Question: In one sentence, what is this figure communicating?
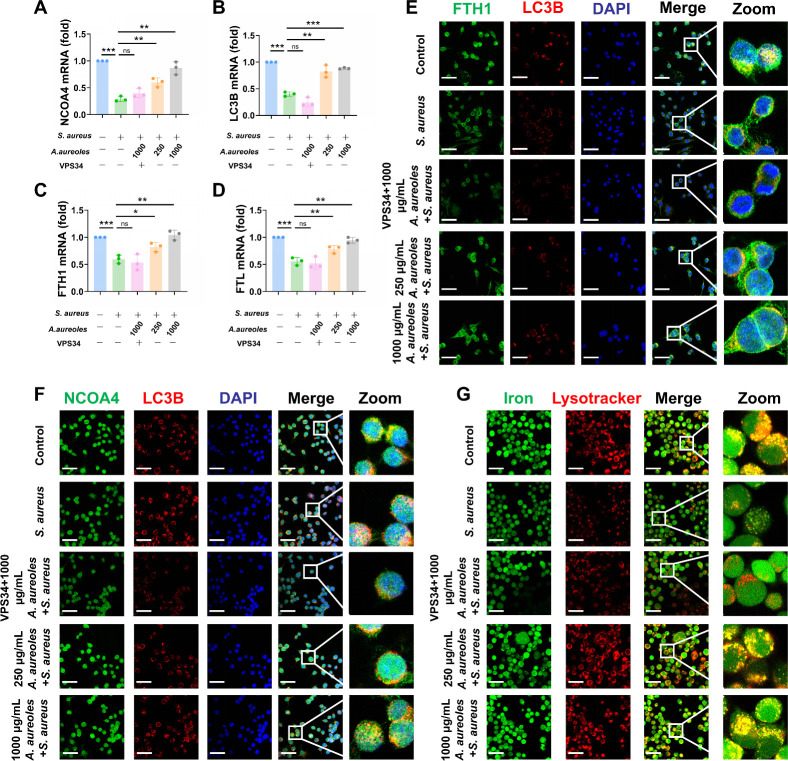
Answer: A. aureoles GGNSJ001 protects RAW 264.7 cells against S. aureus -triggered ferritinophagy. RAW 264.7 cells were treated with S. aureus (MOI = 10) for the indicated time. VPS34 and A. aureoles GGNSJ001 were added to RAW 264.7 cell culture medium before and after S. aureus infection for the indicated time. The relative mRNA levels of NCOA4 ( A ), LC3B ( B ) , FTH1 ( C ), and FTL ( D ) were assessed by q-RT-PCR. RAW 264.7 cells were subjected to immunofluorescence microscopy with antibodies against FTH1 (green) / LC3B (red) ( E ) and NCOA4 (green) / LC3B (red) ( F ). The content of Fe 2+ in lysosomes was determined using Calcein-AM (green) and Lyso-Tracker Red probes ( G ). The error bars represent the standard error of the mean. * P < 0.05, ** P < 0.01, and *** P < 0.001. All data are representative of three independent biological experiments performed in triplicates.